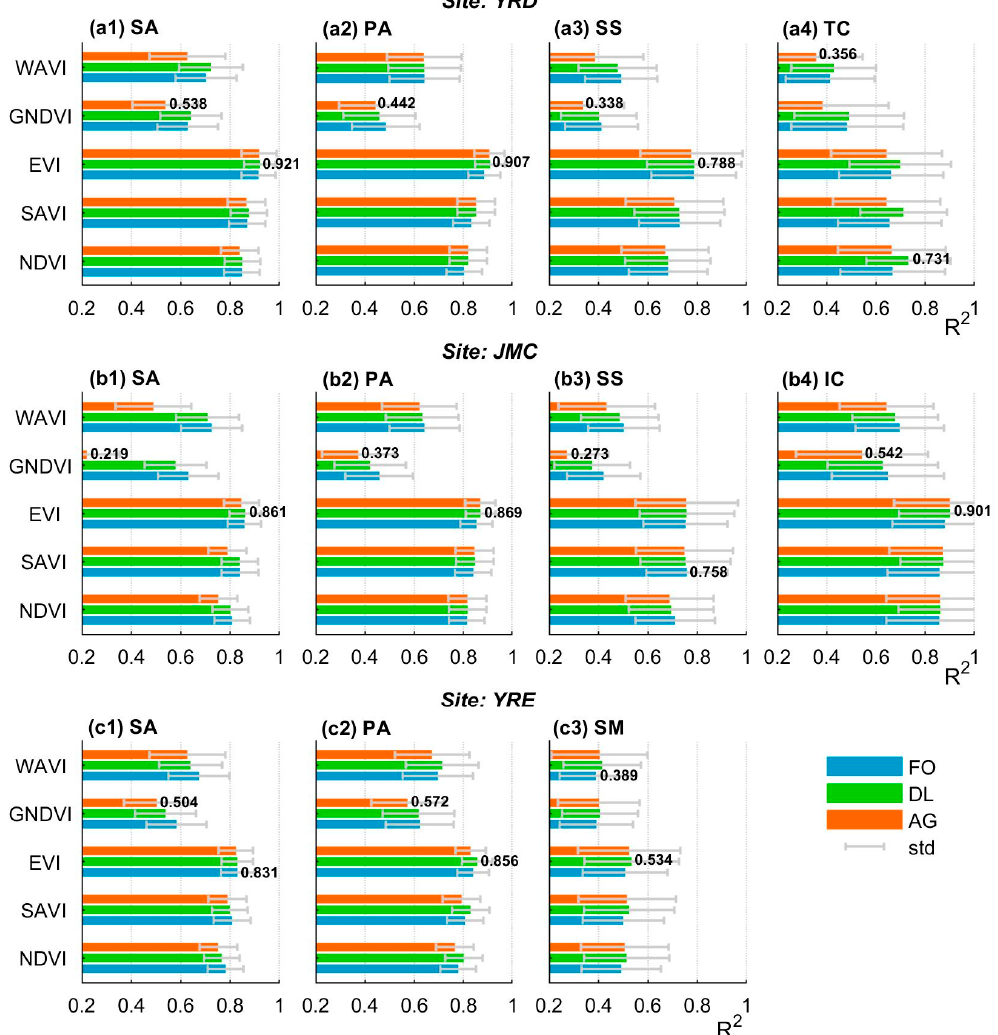
Figure 6. Fitting accuracy of the VI time series-based curve fitting model. Each sub-figure within the same row corresponds to different salt marsh vegetation types within the same site, whilst the two numerical labels for each sub-figure denote the maximum and minimum fitting accuracies. Note: SA = S. alterniflora , PA = P. australis , SS = S. salsa , TC = T. chinensis , IC = I. cylindrica , and SM = S. mariqueter ; for the curve fitting model, AG = Asymmetric Gaussian, DL = Double Logistic, and TF = Two-term Fourier.